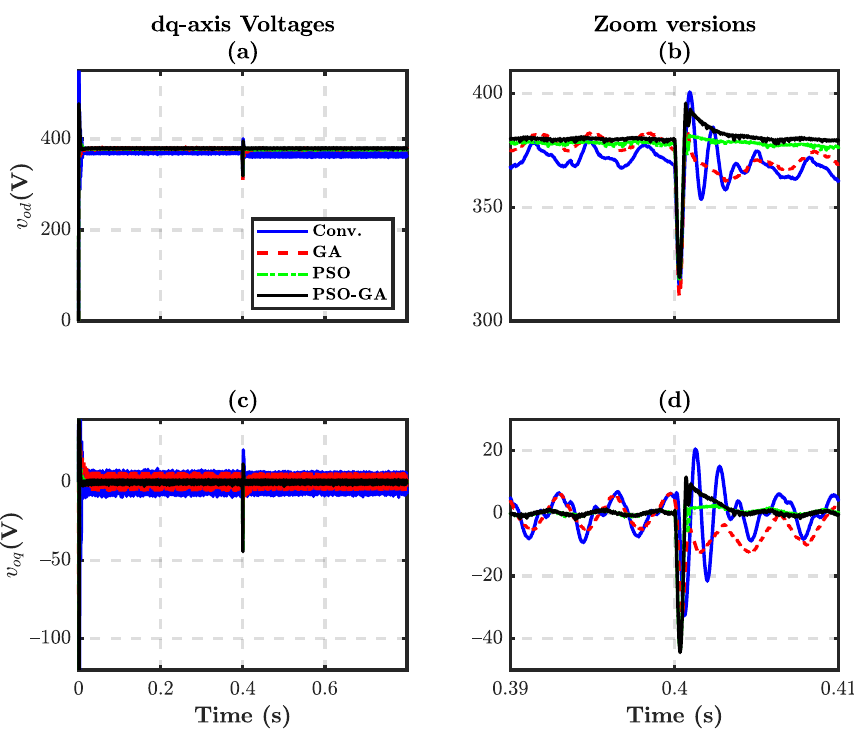
Figure 23. The dq -axis output voltage with different designed parameters under nonlinear load changes: ( a ) d -axis voltage; ( b ) d -axis voltage zoom version; ( c ) q -axis voltage; ( d ) q -axis voltage zoom